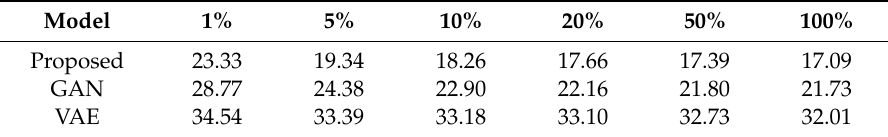
Table 6. FD001 RMSE Unsupervised Feature Learning—Fixed Labeling